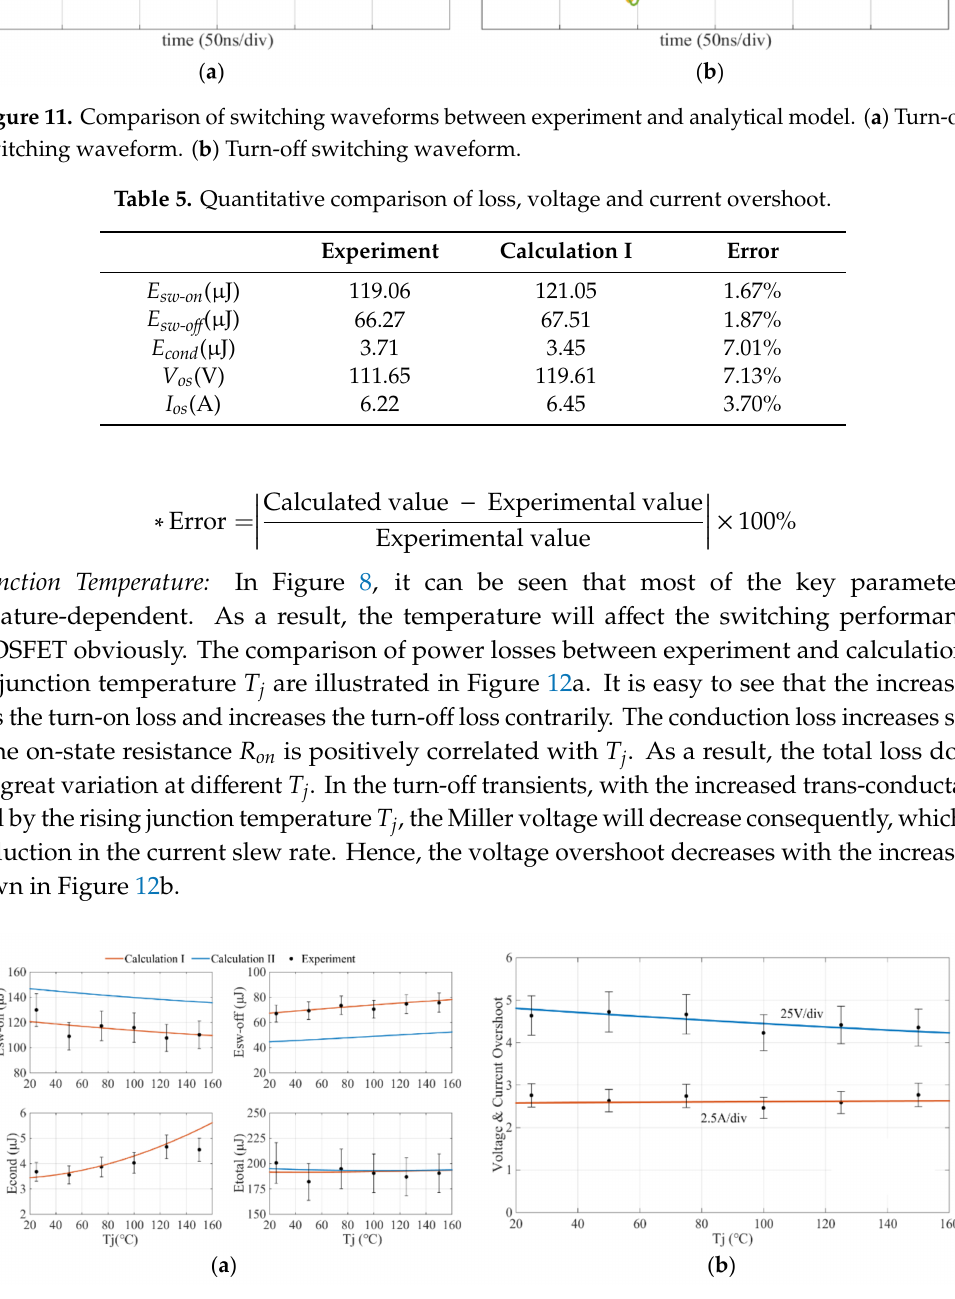
Figure12. Comparisonbetweenexperimentandcalculationundertheinfluenceofjunctiontemperature T j . ( a ) Power losses. ( b ) Voltage overshoot and current